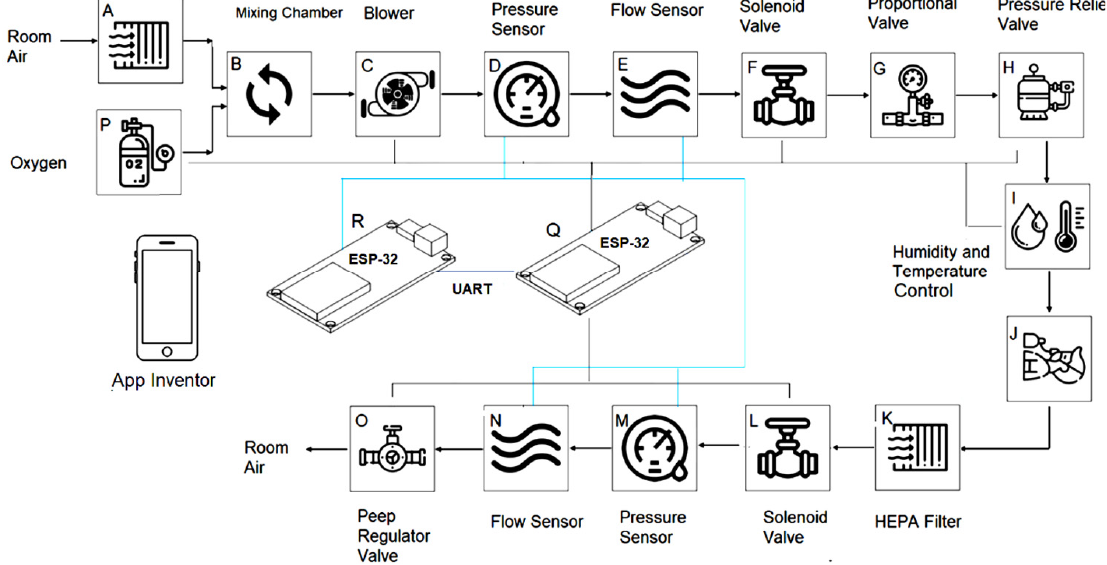
Figure 1. Pneumatic circuit diagram and electronic diagram. Components joining black line are actuators, while the components joining the blue lines are sensors.